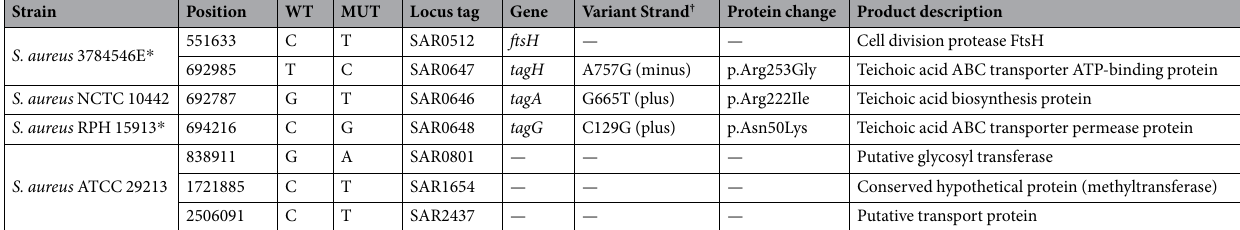
Table 5. Analysis of heterozygous sites in wildtype and mutant strains of S. aureus . WT, wildtype. MUT, mutant. MRSA-252 Genbank accession BX571856. * Clinical isolates. p. denotes amino acid change. † Base pair change on forward (plus) or reverse (minus) DNA